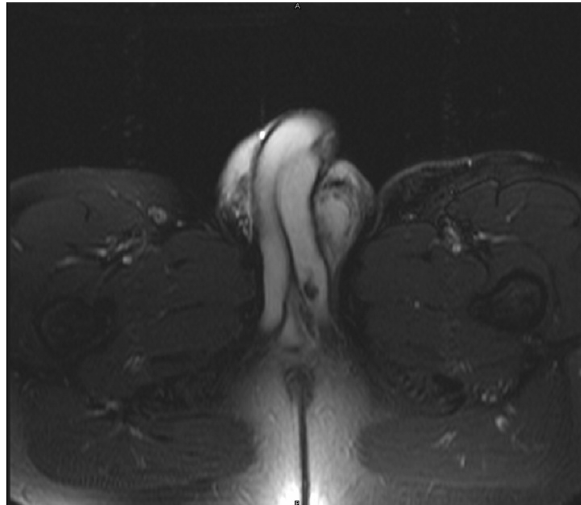
visualization of soft tissue pathological process- es (5). MRI is an adjunctive tool in the evalua- tion of atypical presentations of suspected pe- nile fracture